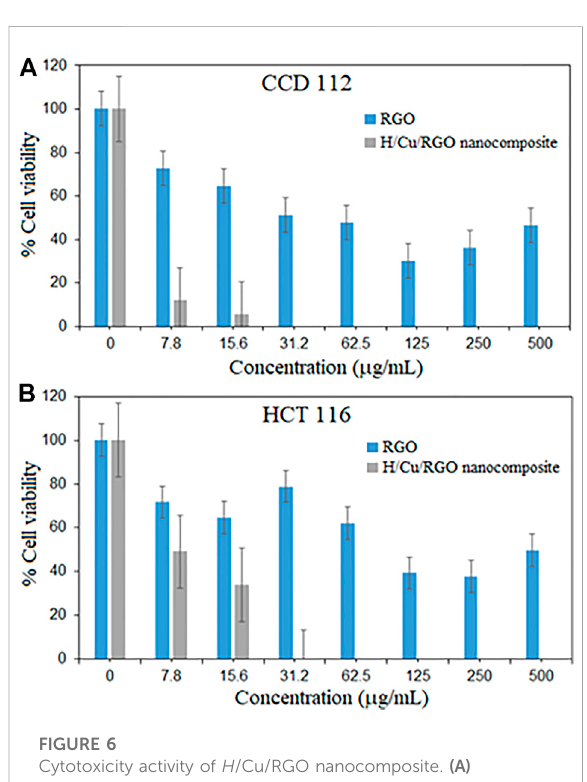
FIGURE 6 Cytotoxicity activity of H /Cu/RGO nanocomposite. (A) Normal colorectal cell line (CCD1 112). (B) Colorectal cancer cell line (HCT